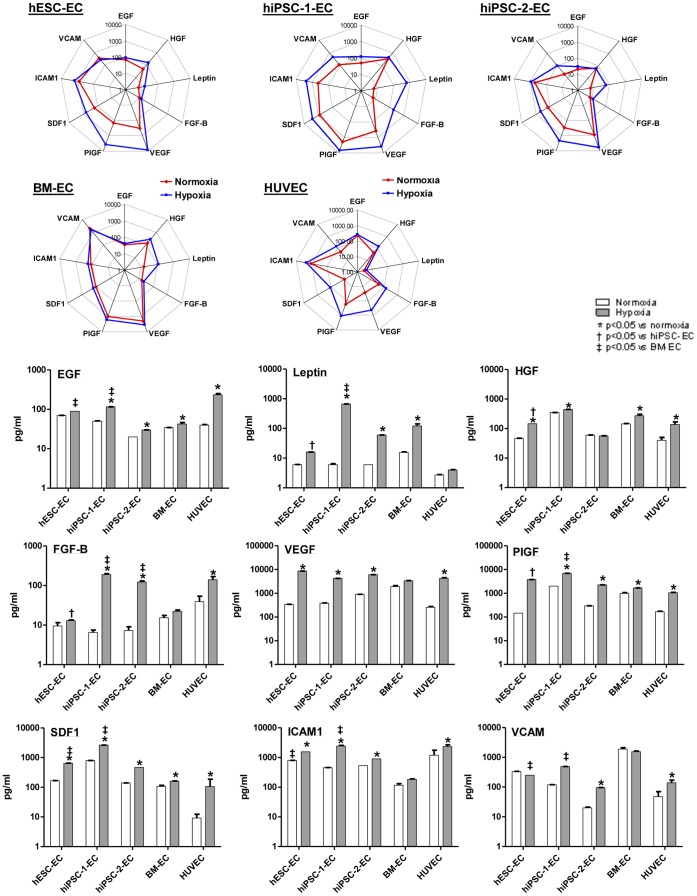
Angiogenic cytokine profiles of conditioned medium obtained from derived endothelial-like cells under normoxic and hypoxic condition.A total of 1×105 cells were plated into 6-well gelatin coated plate for overnight incubation, then the cells were washed and cultivated in EBM2 basal medium without supplement for 5 days under normoxic (20% O2) or hypoxic (0.1% O2). Cytokine profiling of their conditioned mediums obtained were determined by Procarta multiplex bead-based immunoassay kit. (A) Bar charts and (B) multivariate radar chart showed the expression of epidermal growth factor (EGF), basic fibroblast growth factor (FGF-B), hepatocyte growth factor (HGF), leptin, vascular endothelial growth factor (VEGF), placental growth factor (PIGF) and stromal derived factor-1 (SDF-1); adhesion molecules including, ICAM1 and vascular cell adhesion molecule (VCAM) in the conditioned medium upon normoxic and hypoxic treatment.